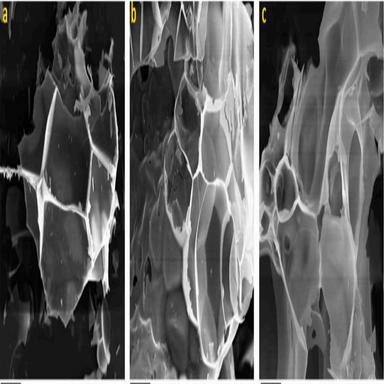
SEM images of EP (a,b,c) and EP/RT27 composite (d,e).